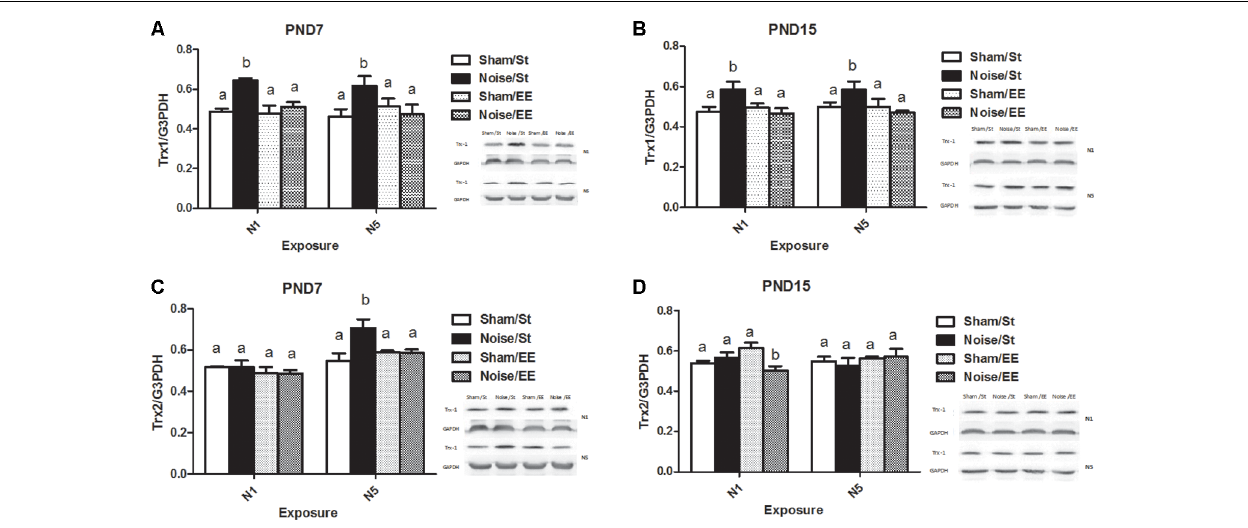
FIGURE 9 | Hippocampal Thioredoxin (Trx) levels.Trx-1: (A) PND28 animals exposed at PND7; (B) PND28 animals exposed at PND15. Trx-2: (C) PND28 animals exposed at PND7; (D) PND28 animals exposed at PND15. Sham: non- exposed animals; N1: single noise exposure; N5: five-daily noise exposure. St: standard housing. EE: enriched environment. Different letters (a, b) symbolize significant differences with p < 0.05. Data represent the mean ± SEM of the levels of hippocampal Trx-1 or Trx-2, n = 4 for each